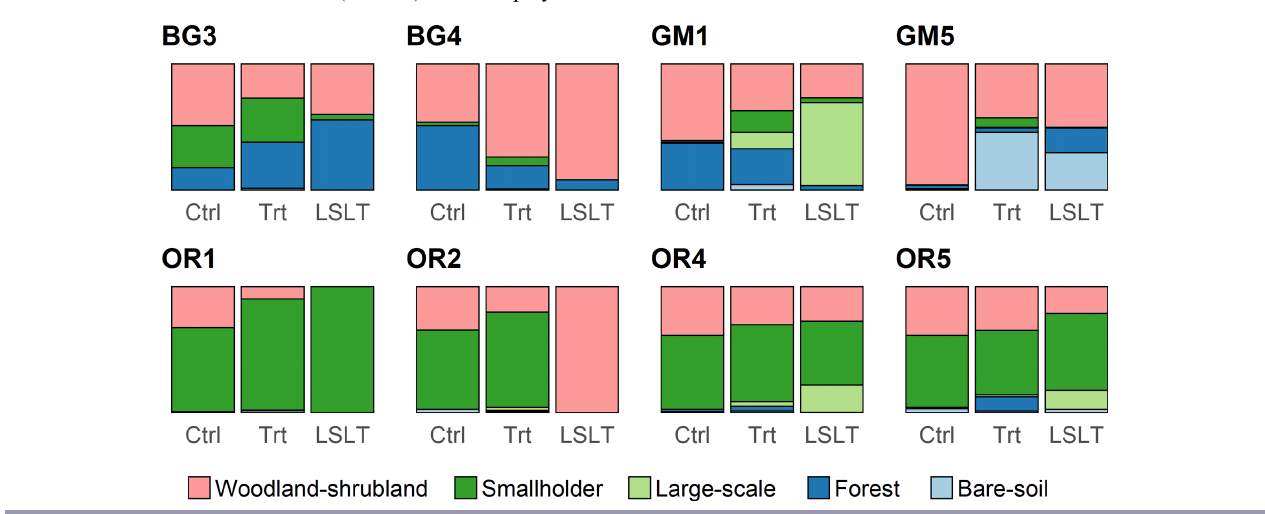
Fig. 2 . Site-level land use and land cover (LULC) in the Pre-LSLT (large-scale land transaction) period. The “Trt” bars represent the buffer area in each treatment site (i.e., surrounding the LSLT). The “Other” class (Table 1) is not displayed.